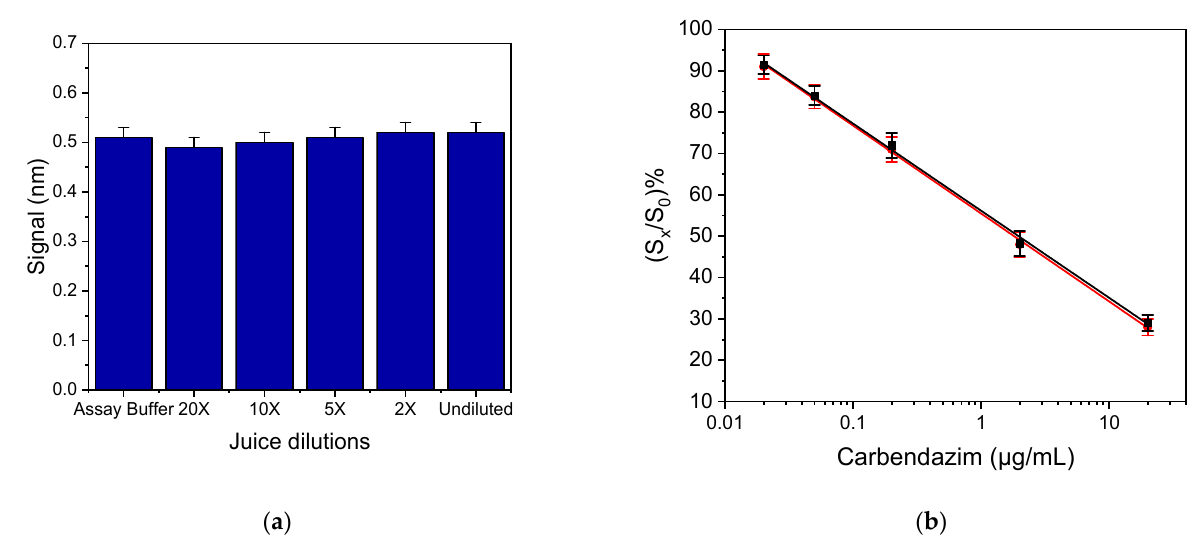
Figure 5. ( a ) Zero standard signal corresponding to assay buffer and filtered and pH-adjusted juice, undiluted and diluted 2 × to 20 × with assay buffer. Each bar represents the mean value of 3 independent measurements ± SD. ( b ) Typical calibration plots obtained with carbendazim standards prepared in assay buffer (black squares) and treated orange juice (red circles). Each point represents the mean value of 4 runs ± SD.